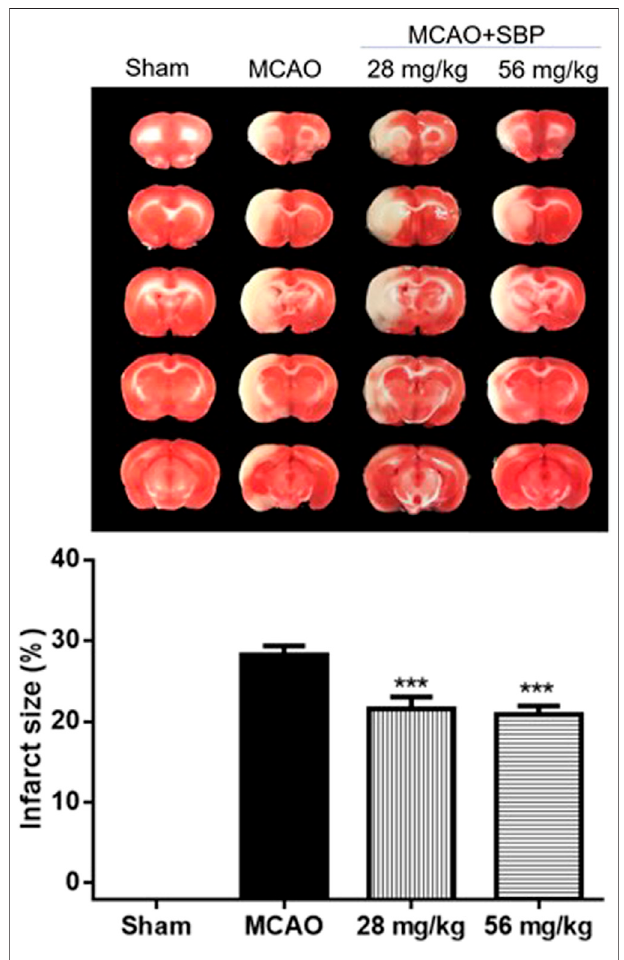
FIGURE 2 | SBP reduces cerebral infarction at the early stage of stroke in rats 24 h after ischemia/reperfusion injury. Data are expressed as mean ± SEM, n (cid:2) 8; *** p < 0.001 compared to